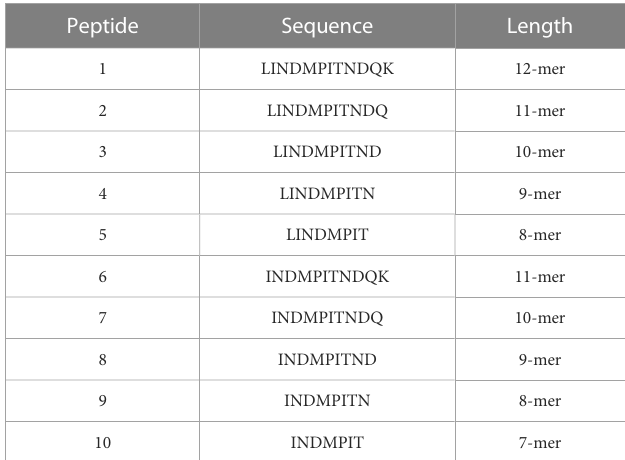
TABLE 2 BRSV F protein C-terminal truncated peptide